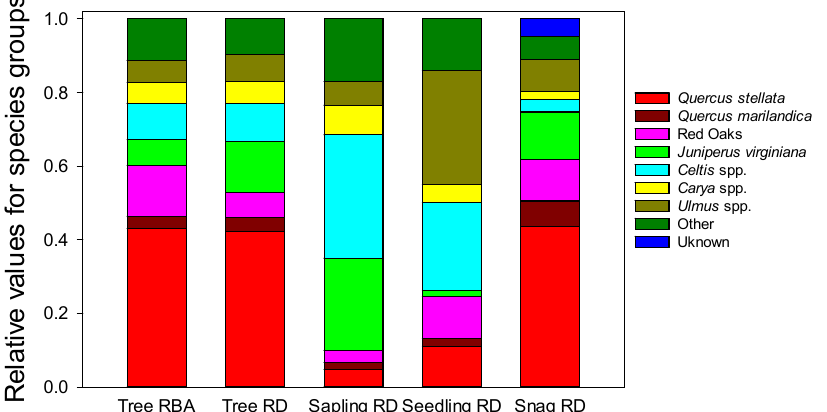
Figure 3. Tree relative dominance based on basal area (Tree RBA) as well as overstory tree, sapling, seedling, and snag relative density (RD) measured in Cross Timbers forests of north ‐ central Oklahoma. Categories are either individual species or groupings of related species.